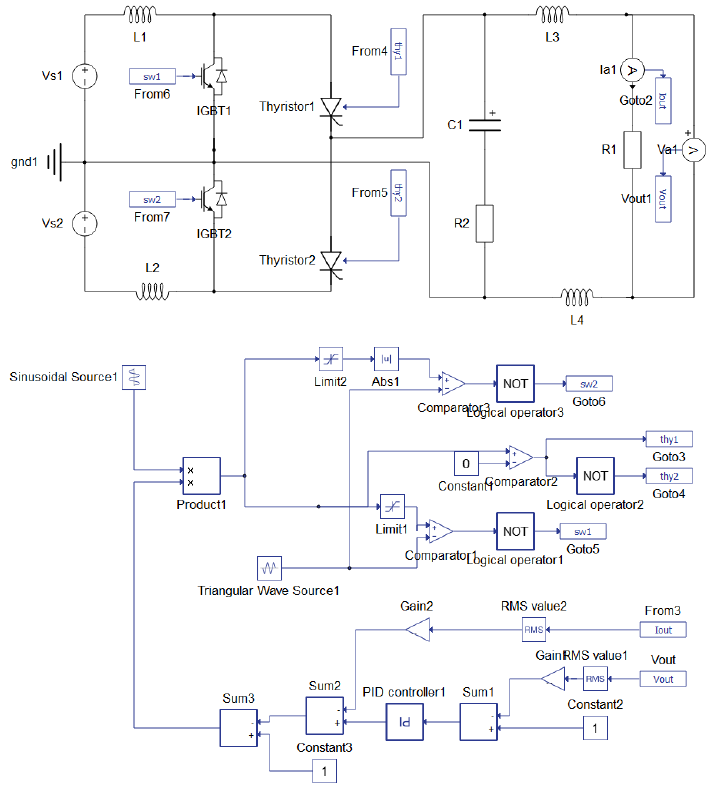
Figure 13. The proposed topology design with control using the HIL